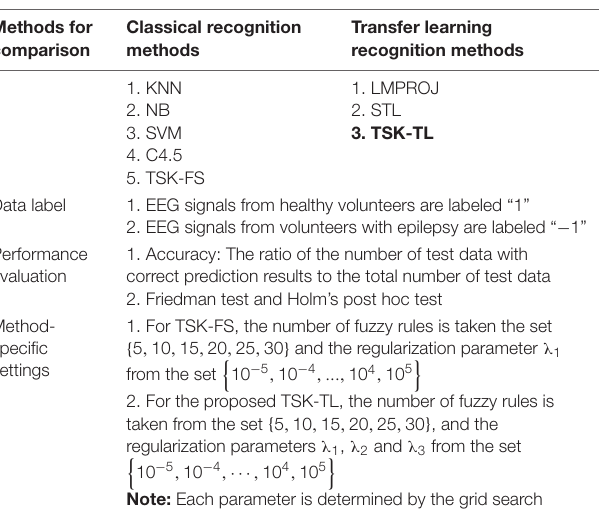
TABLE 3 | Experimental